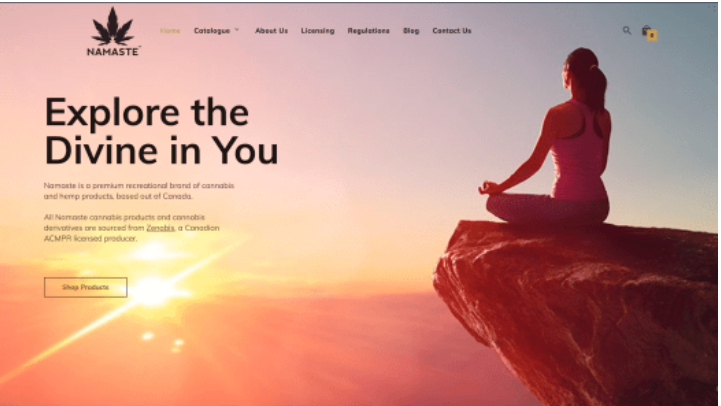
Figure 5. Homepage for Namaste.com.